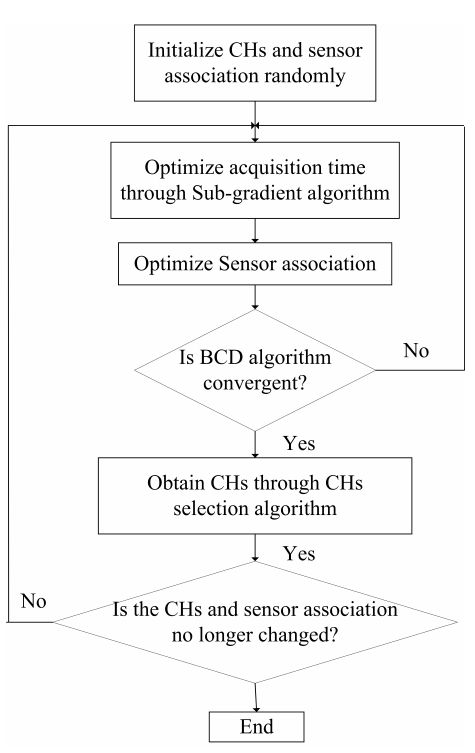
Figure 2. The flowchart of the ATSAO